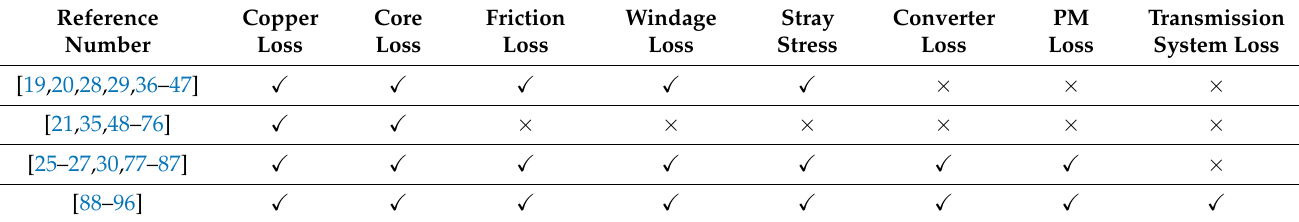
Table 1. The type of losses investigated for EM calculation during the last three decades (1992 to 2021).